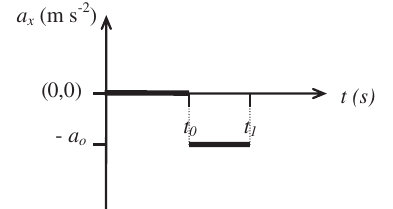
FIG. 1. Kinematic task with graphical format requesting quali- tative solution.